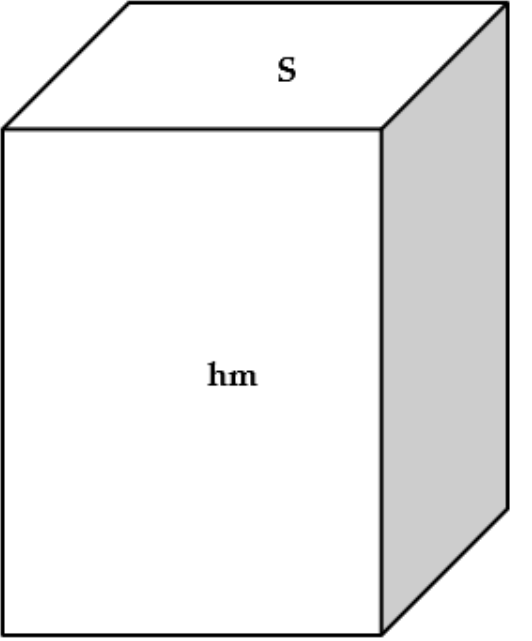
Figure 9. Bv = S × hm × Cm: Bv = biovolume, S = surface, Cm = medium herbaceous cover, Figure 9. Bv = S x hm x Cm: Bv = biovolume, S = surface, Cm = medium herbaceous cover, hm = hm = average height of the dominant average height of the dominant species.